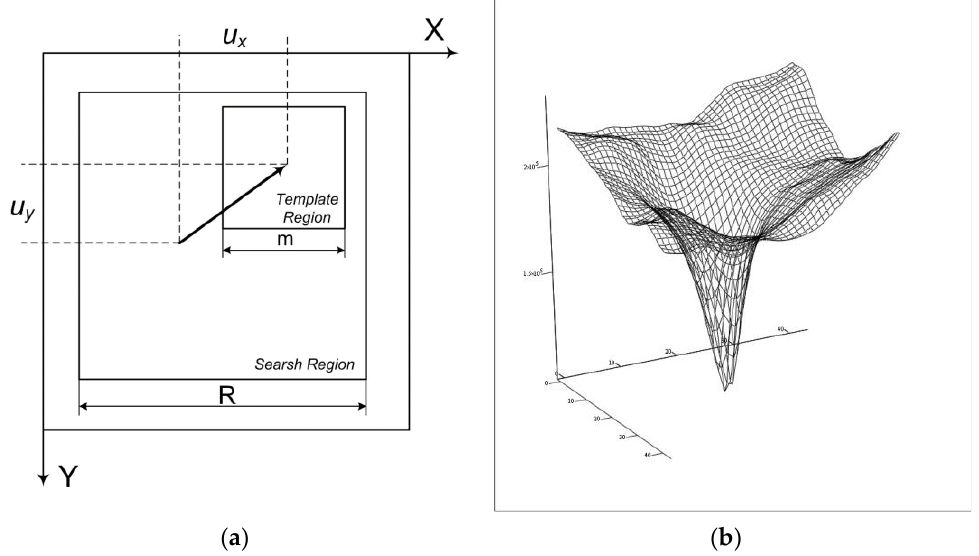
Figure 1. Scheme explaining the operation of the block identification algorithm ( a ) and a typical form of the difference functional ( b ).